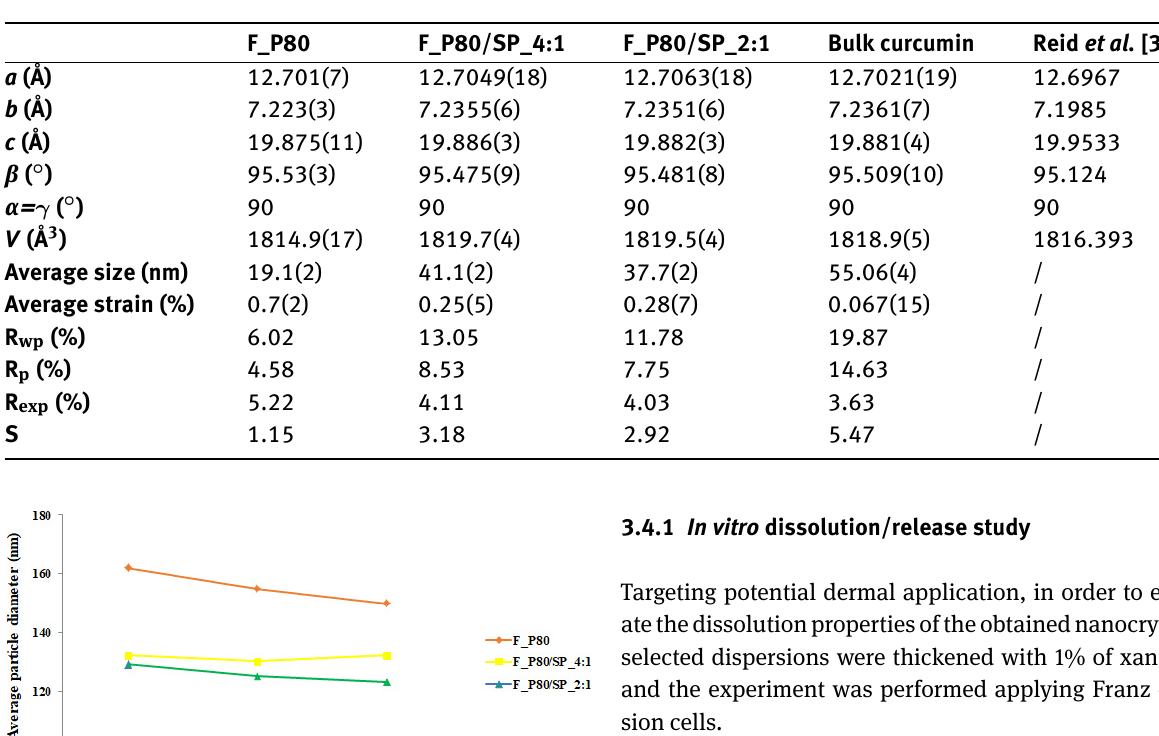
Table 5: Refined unite cell parameters, average crystallite size * and average strain for: F_P80, F_P80/SP_4:1, F_P80/SP_2:1 and bulk curcumin. Unite cell parameters for reference curcumin [39] is also present as well as reliability factors of the WPPF refinement R wp , R p ,